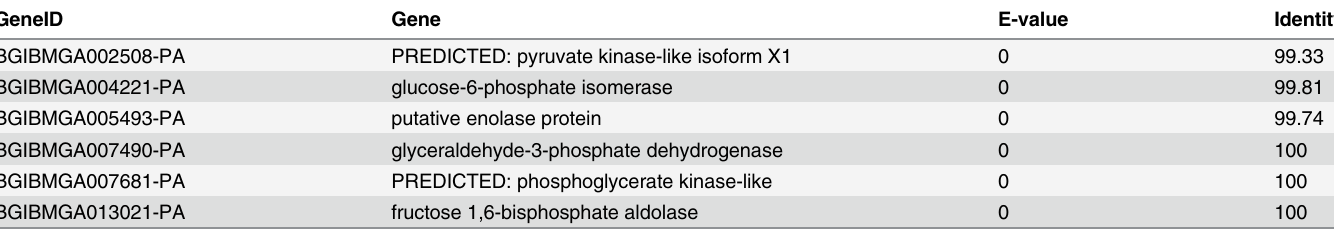
Table 3. The up-regulated genes that are associated with glycolysis in the